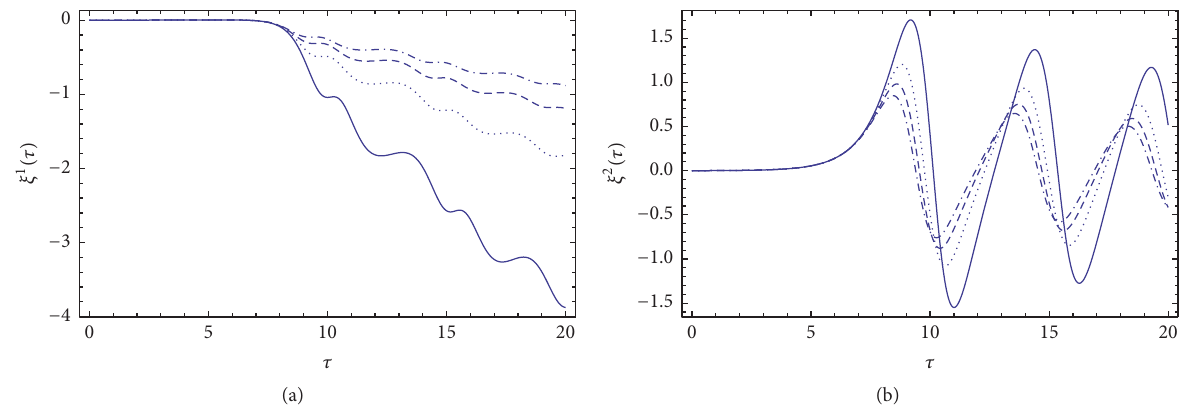
Figure 10: Time variations of the deviation vector components 𝜉 1 (a) and 𝜉 2 (b) for a Universe filled with a Higgs type scalar field, for different values of the parameter 𝜂 : 𝜂 = 10 (solid curve), 𝜂 = 20 (dotted curve), 𝜂 = 30 (dashed curve), and 𝜂 = 40 (dashed dotted curve).